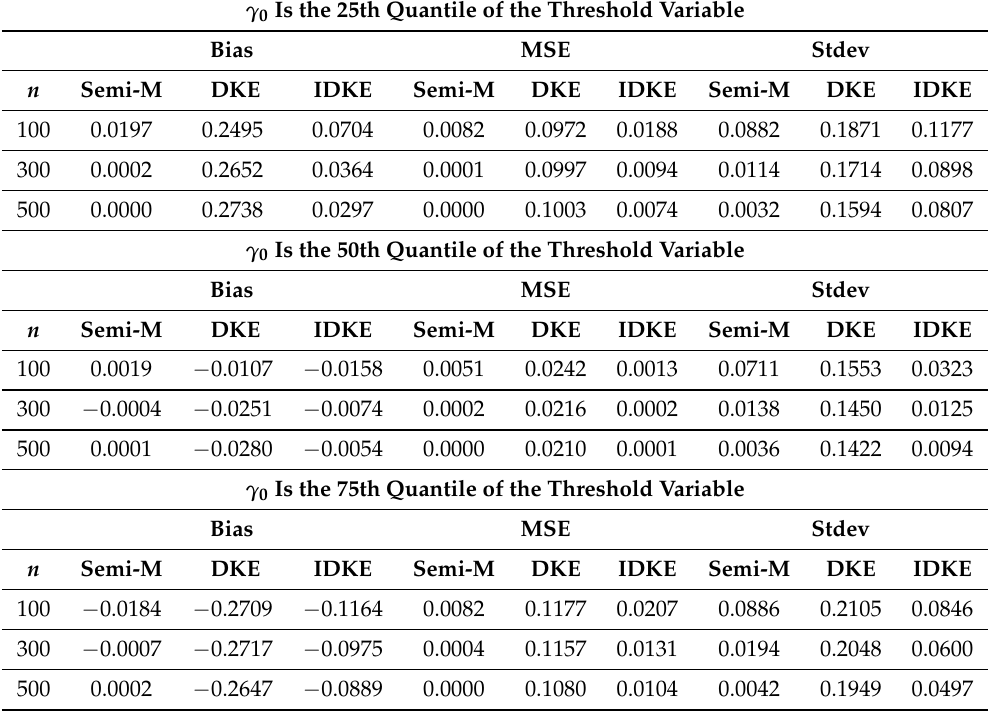
Table 6. Simulation results of nonparametric threshold estimators, DGP